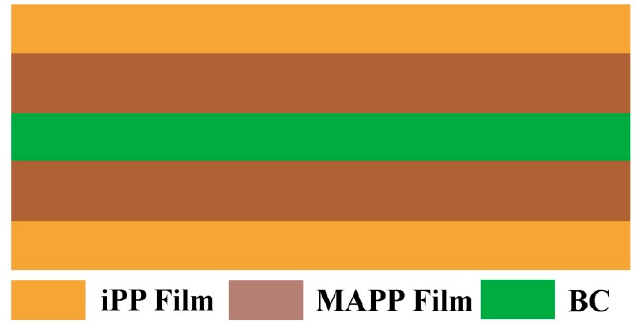
Figure 1. Schematic diagram of iPP/BC hamburger composites.